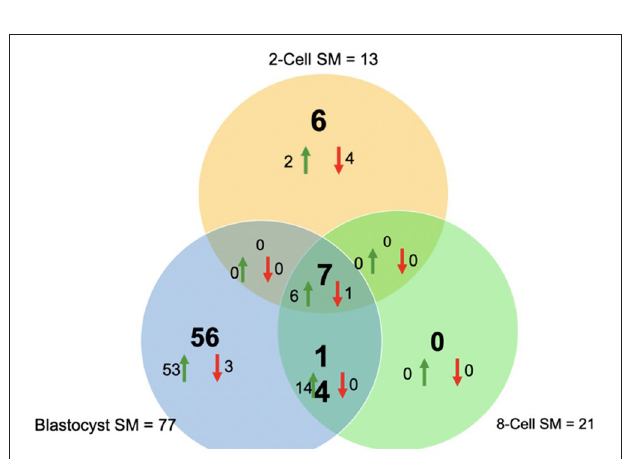
FIGURE 2 | Venn diagram of differentially expressed miRNAs from 2-cell (yellow), 8-cell (green), and blastocyst SM (blue). Overlapping results showed differentially expressed miRNAs shared between 2 or more groups (14 miRNAs between 8-cell and blastocyst spent media; 7 miRNAs between all 3 spent media